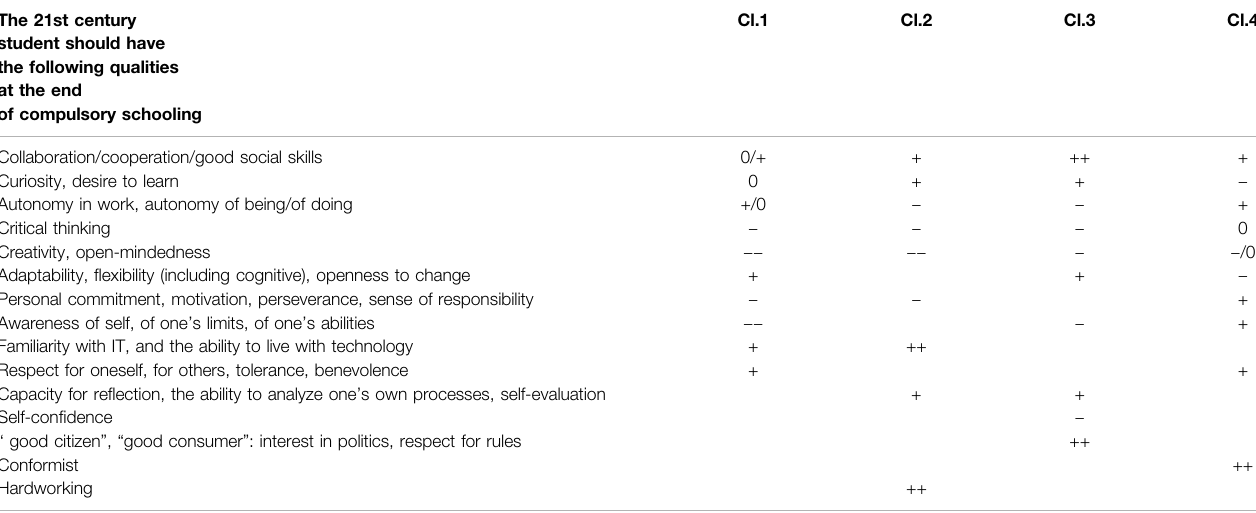
TABLE 2 | The “ qualities ” that teachers believe the 21st century student should